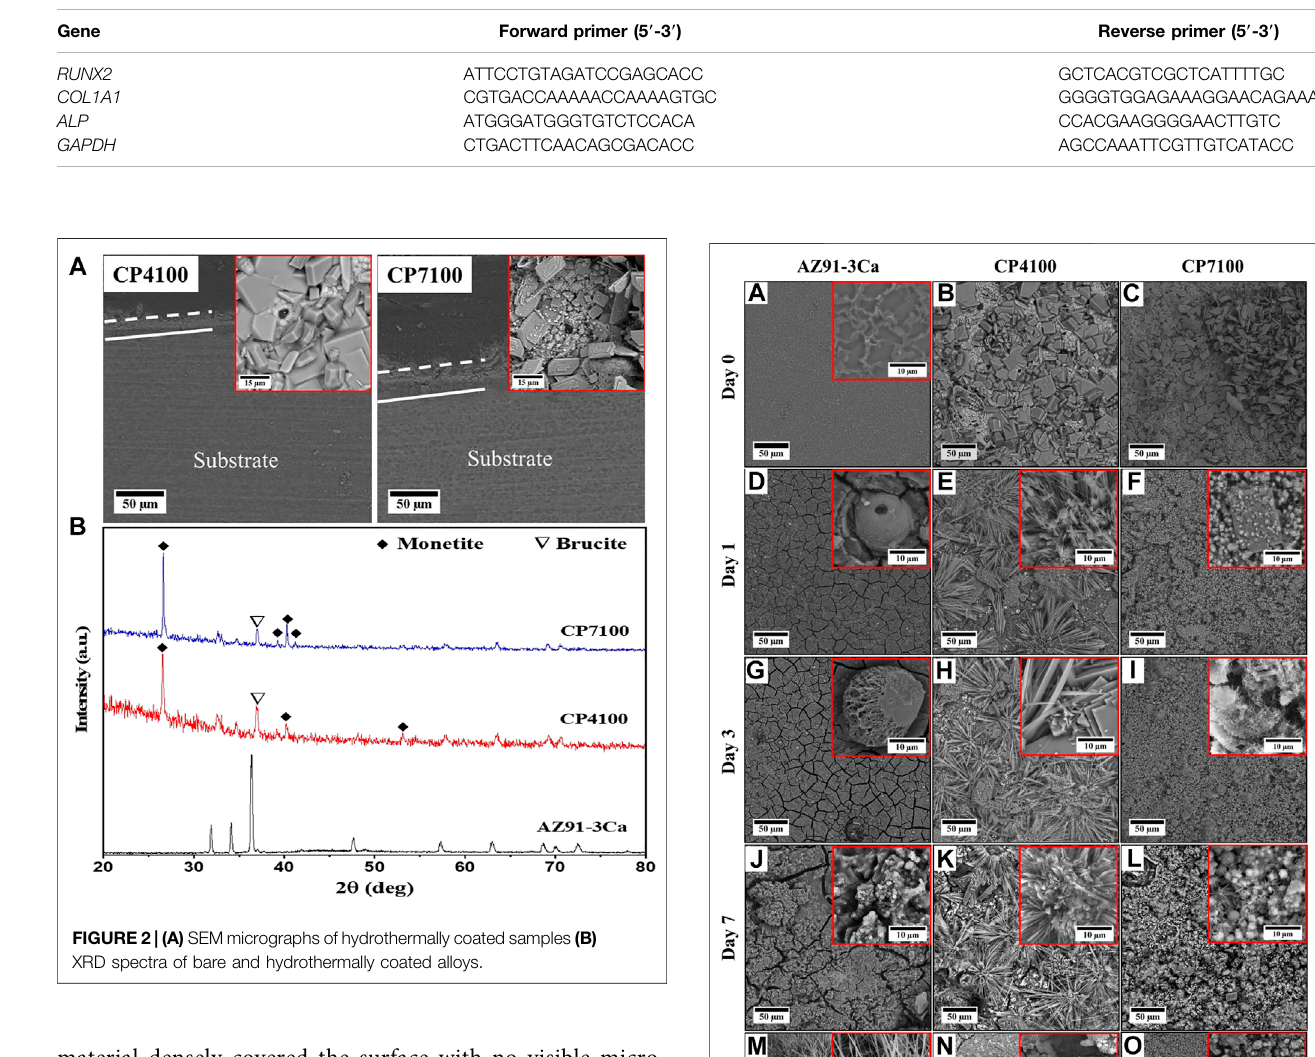
TABLE 2 | Primers sequences used for qRT-PCR.